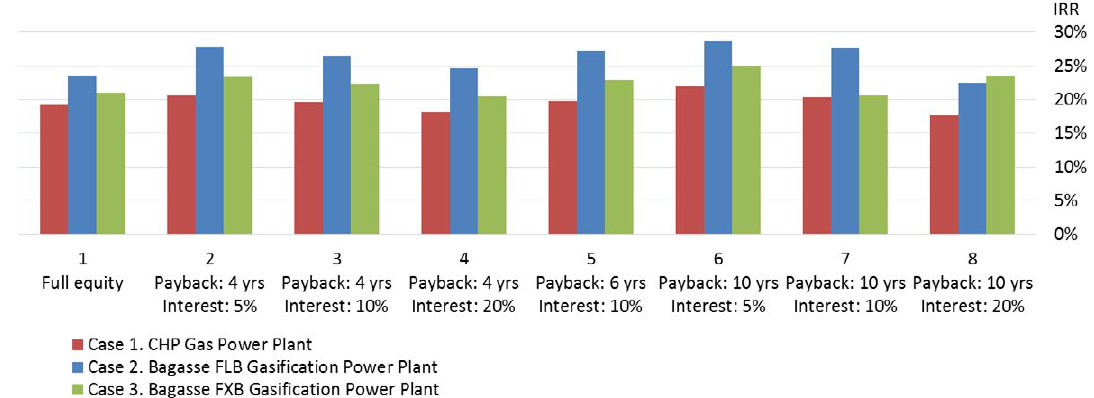
Fig. 2: IRR results of financing scenarios for investment plans for power plants with different loan conditions